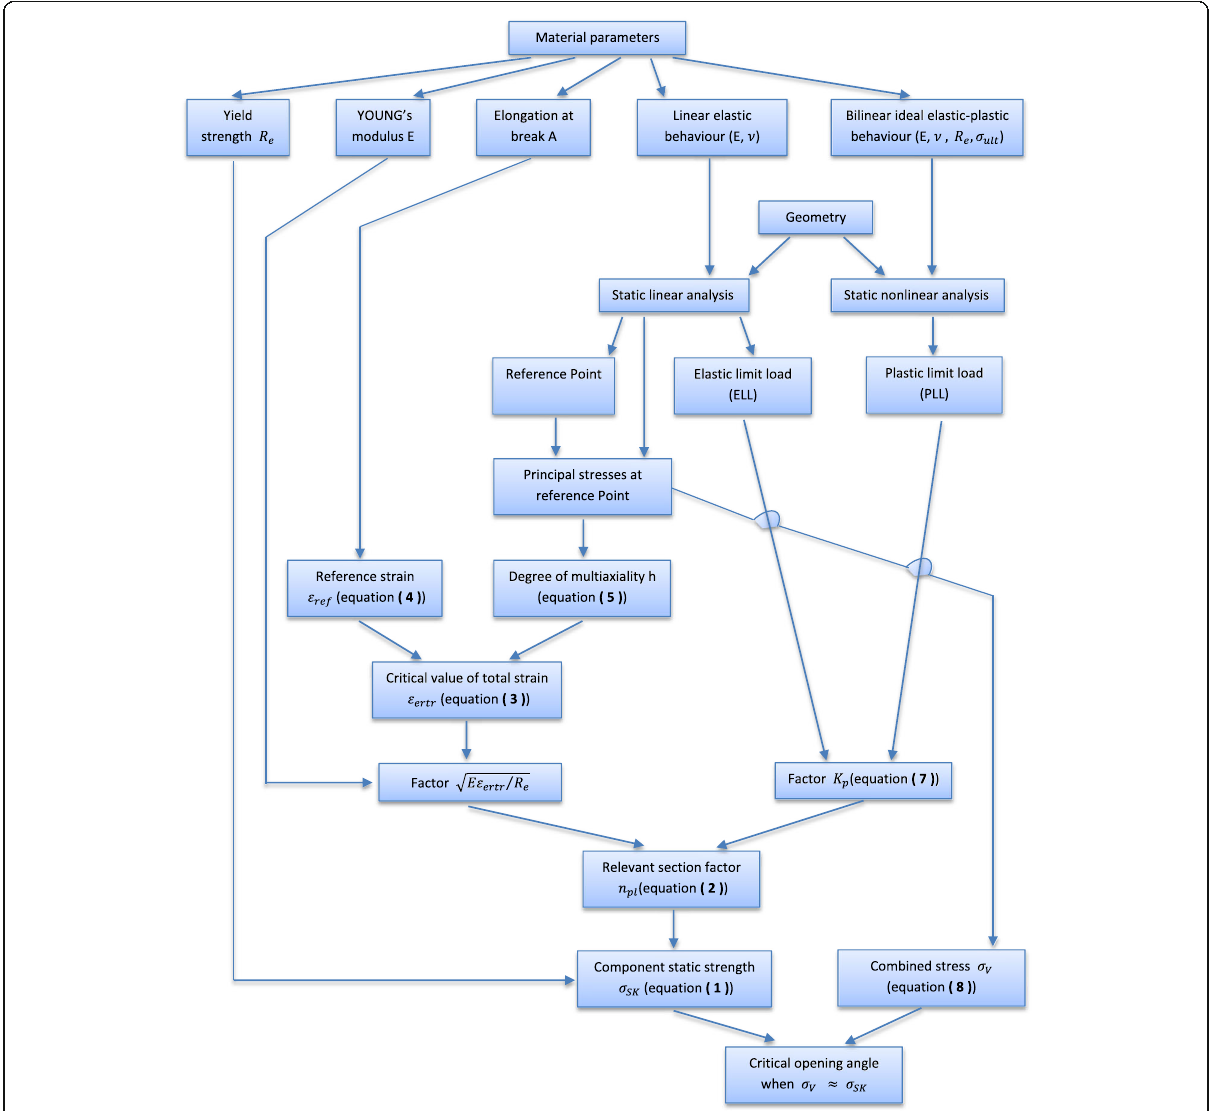
Fig. 4 Procedure used to assess the component static stress and hence determining the critical opening angle: The critical opening angle is reached when the combined stress at the reference point reaches the component static